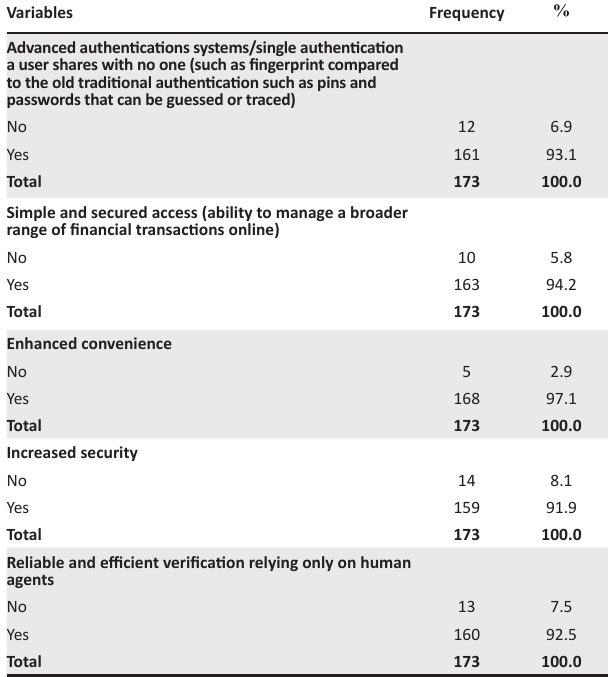
TABLE 5: Biometric connections as